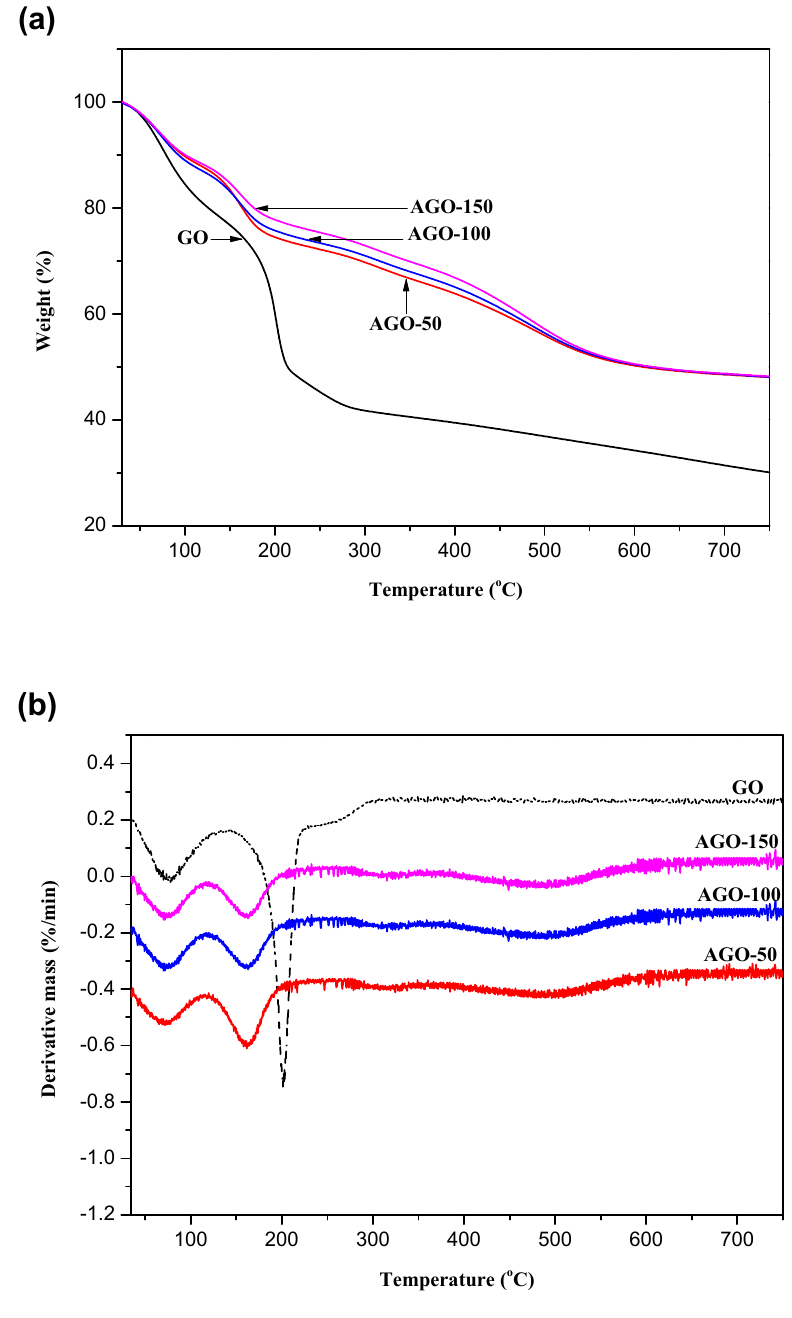
Figure 9. ( a ) TG and ( b ) DTG thermograms of GO, AGO-50, AGO-100, and AGO-150. Table 2. Percentage weight loss of GO and functionalized-GOs at various temperature regions.